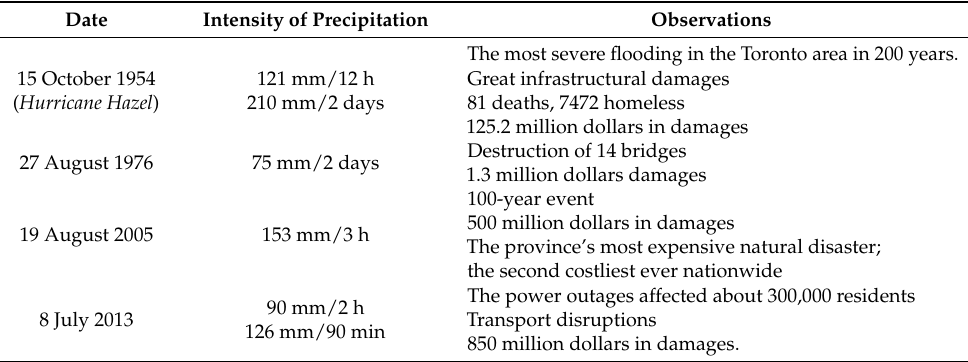
Table 1. A summary of the four major floods in Toronto.